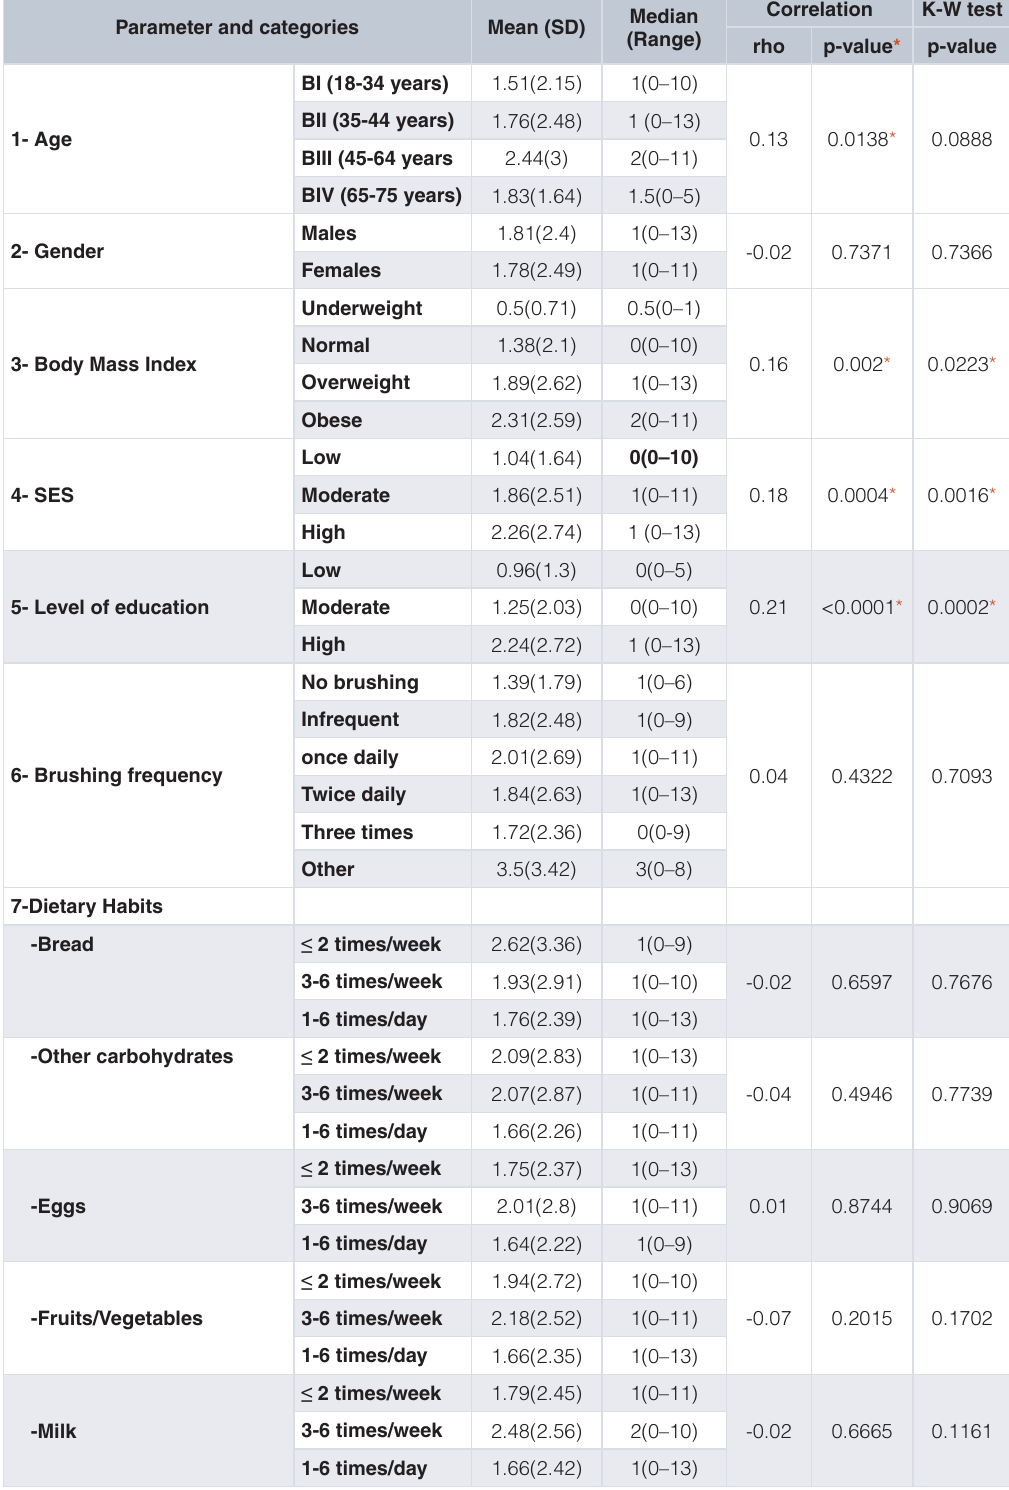
Table 5 . Filled teeth and different risk factors